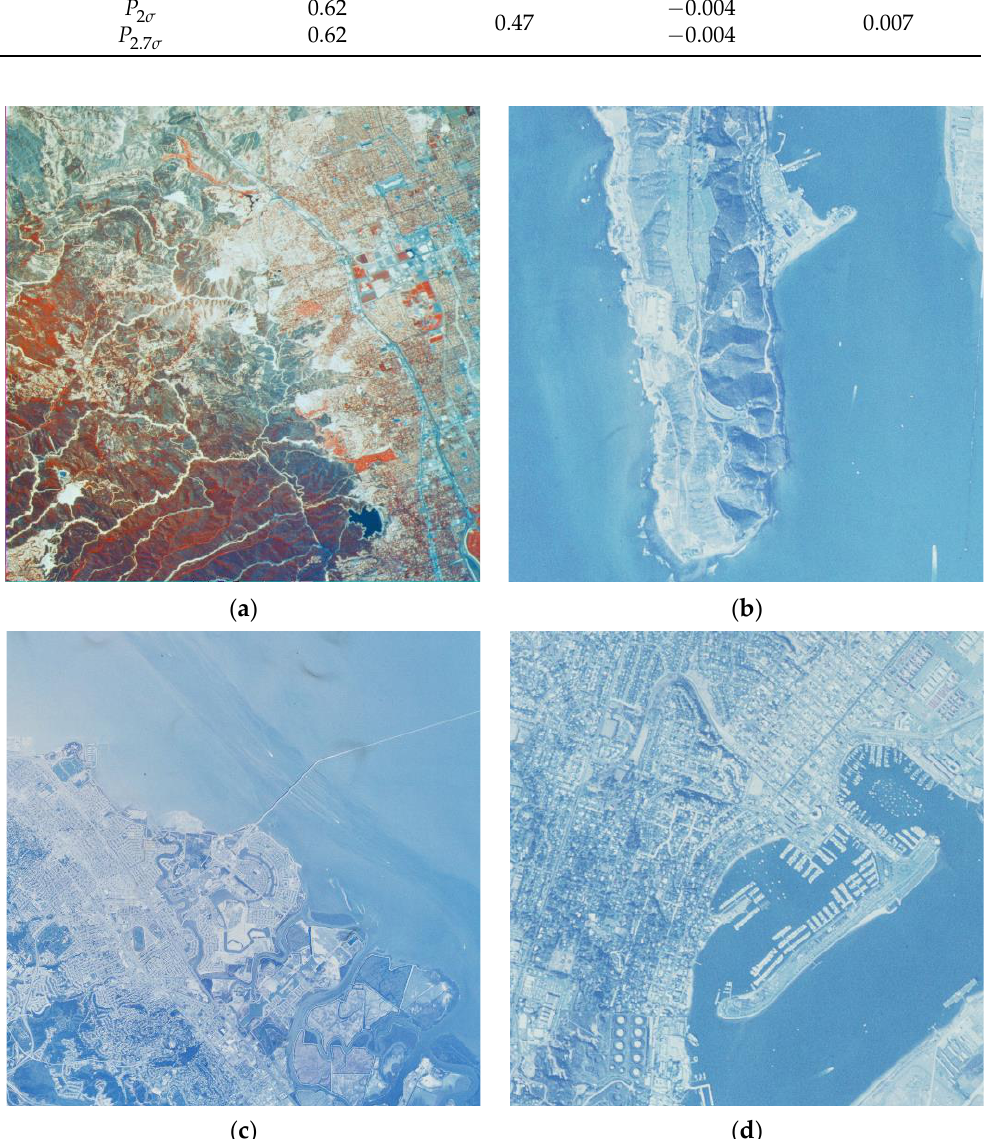
Figure 9. Test three-channel images Woodland Hills ( a ), Point Loma ( b ), Foster City ( c ), and Shelter Island ( d ), all 512 × 512 pixels. Table 2. Predicted and true parameters for verification images compressed with Q OOP .